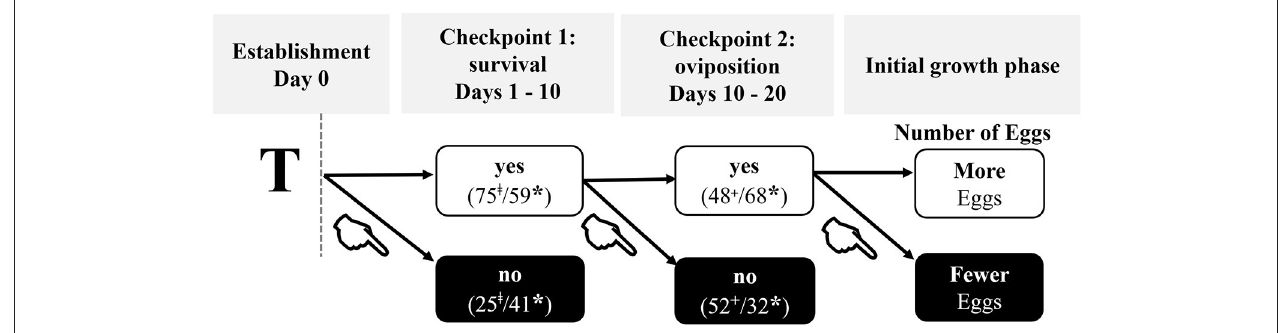
FIGURE 5 | Ontogeny of colony foundation under pathogenic stress. T = treatment was given on the same day as colony establishment. Each checkpoint depicts the overall percent of colonies that either did (YES) or did not (NO) successfully pass through that checkpoint: ‡ , percent at day 10; + , percent at day 20; *, percent at day 30. Checkpoint 1, characterized by whether kings and queens survive pathogenic exposure, is the first hurdle in the successful establishment of a colony. The steepest decline in survival was in the first 10 days post-establishment when 25% of all reproductives died. By day 30, 41% of all reproductives were dead. Checkpoint 2 is characterized by whether a queen engages in egg-laying. Surviving queens oviposited between days 10 and 20 post-establishment. If a queen successfully surpassed checkpoints 1 and 2, then fitness-related costs due to pathogenic stress were evident in a context dependent manner during the initial phase of colony growth: light queens injected with Live- Sm produced fewer eggs by day 30 relative to heavy queens who were similarly treated. = indicates the negative contributions of pathogenic stress on fitness-related